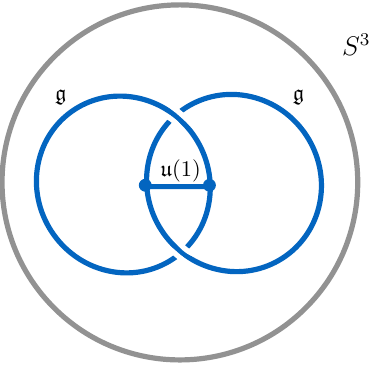
Figure 2 . The S generator corresponds to an S 3 with a Hopf network of defects with (cid:13)avour symmetries as in the